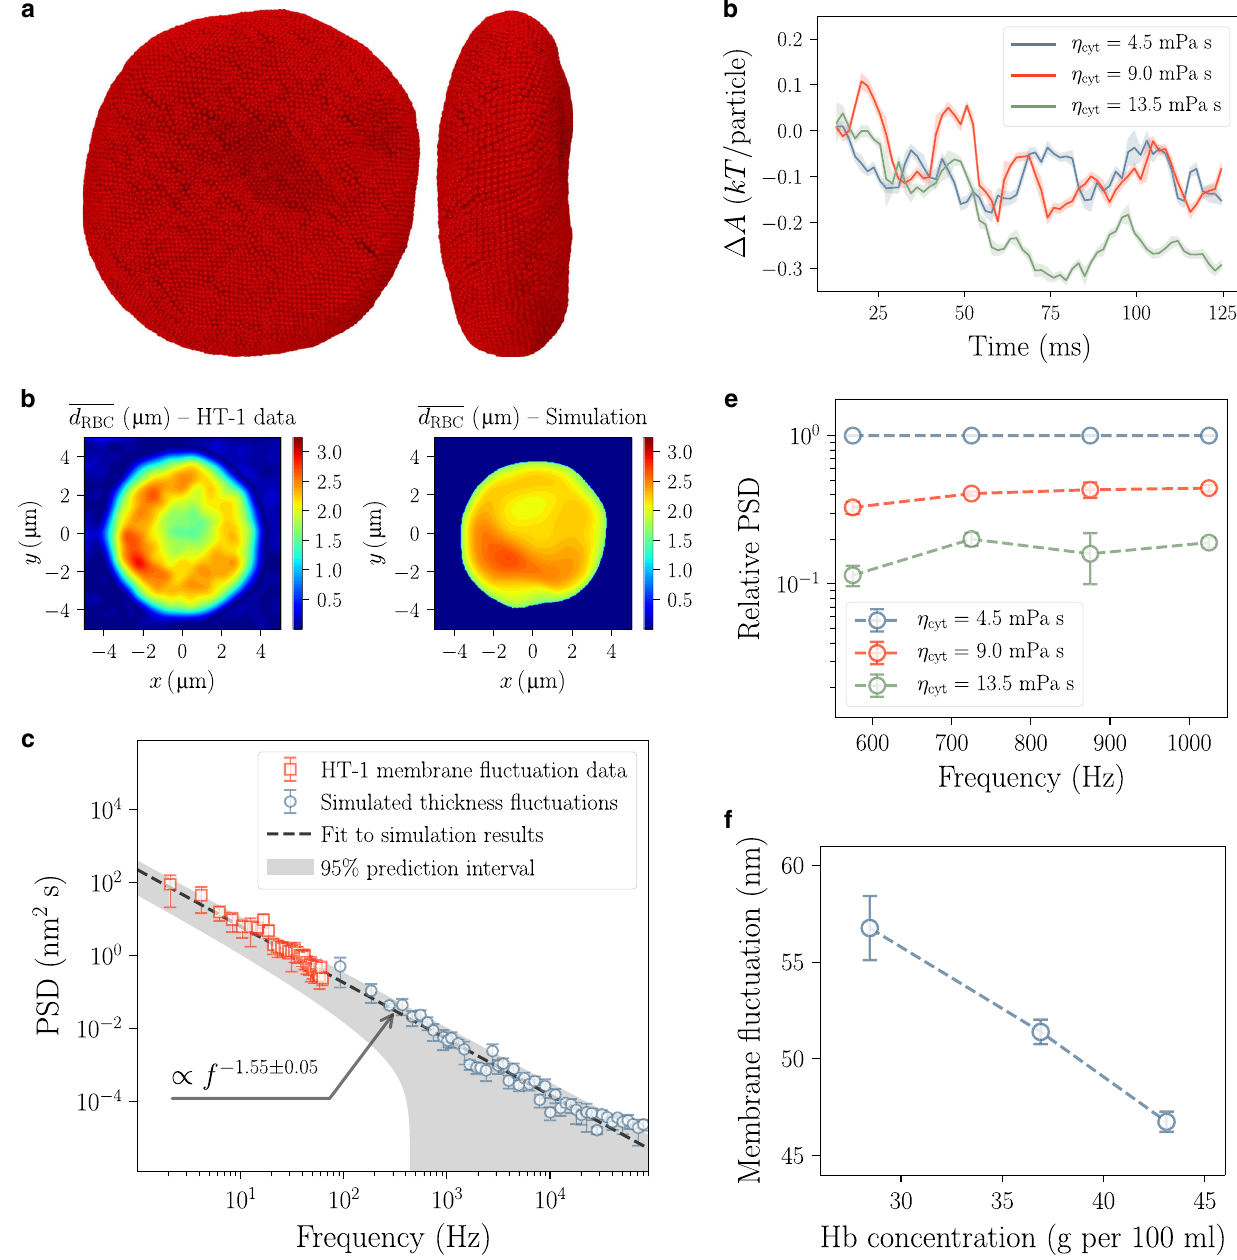
Fig. 6 Simulating the dynamics of a human red blood cell. a Top and side views of a snapshot of the red blood cell as modelled with the mesoscopic membrane model. b Mean cell thickness pro fi les from experimental measurements (holotomography and phase-shift imaging with HT-1 microscope, Tomocube Inc., Republic of Korea) compared with the simulated counterpart. c Power spectral density (PSD) of thickness fl uctuations of the red blood cell for simulation and HT-1 experimental data. The power law is fi tted to the simulation results and extended to the experimental low-frequency range for the sake of comparison. The shaded area corresponds to the prediction interval of the power-law fi t. d Free energy change during the fi rst 125 ms of simulations as a function of time, given for three different choices of the viscosity of the cytoplasm. e Relative PSD for the given viscosities, using the lowest viscosity of η = 4.5 mPa s as the baseline. f Magnitude of large-amplitude membrane fl uctuations versus the haemoglobin concentration of the blood cell cytosol. Error bars or error bands represent standard